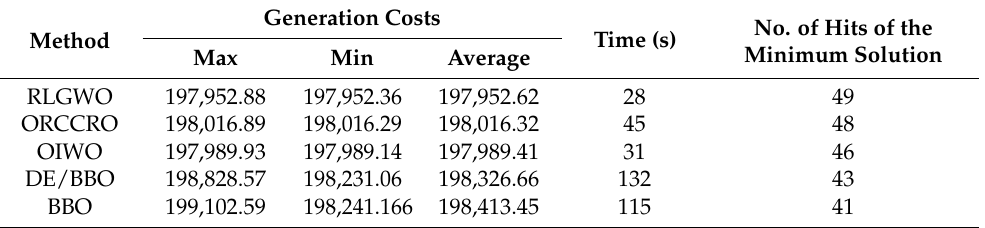
Figure 8. Comparative convergence characteristics of the original GWO and the proposed RLGWO algorithms for the 110-unit system. Table 6. Comparison between different methods taken after 50 trials (110-unit system with